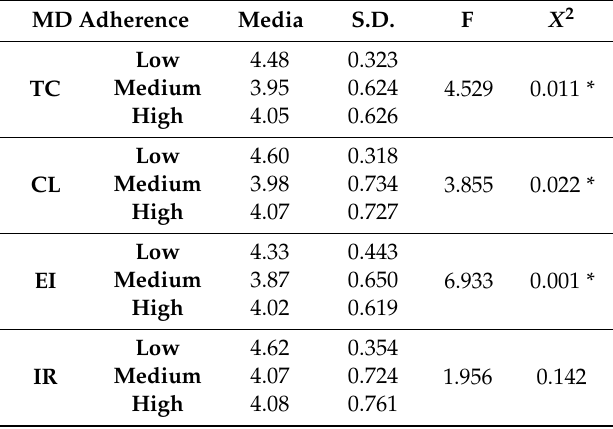
Table 2. Motivational climate and MD adherence. MD